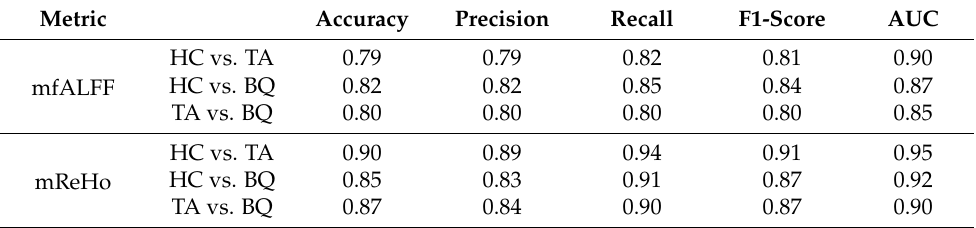
Table 3. Classification results for different groups with each